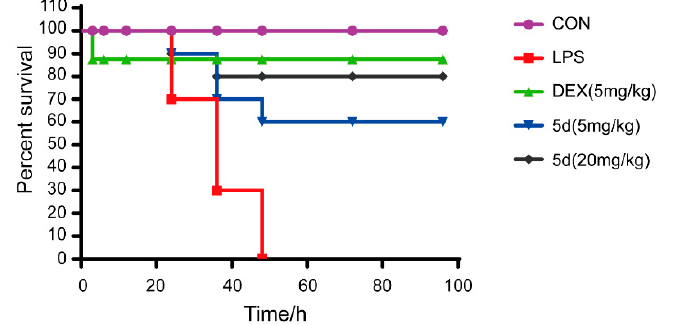
Figure 10. Mouse survival curve of the compound 5d on endotoxemic mice. Mice in experiment groups were treated with LPS (4 mg/kg, i.p.), and the 5d -treated groups were injected with 5d (5, 20 mg/kg, i.p.) at 0, 3, 12, 24, 48 and 72 h after LPS administration. DEX group mice were injected with DEX (5 mg/kg, i.p.) after LPS treatment. The survival rate was recorded for the next 96 h ( n = 10).